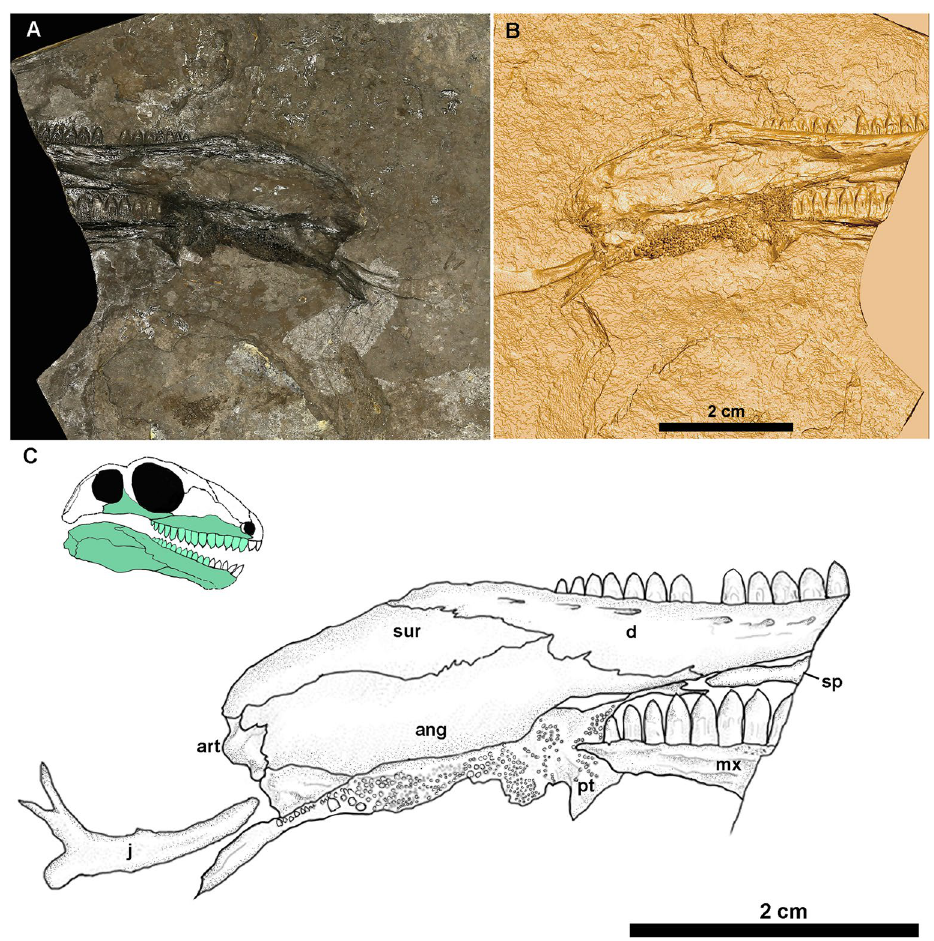
Figure 1. Holotype of Melanedaphodon hovaneci gen. et sp. nov., CM 93778. ( A ) Photograph showing the negative relief/natural mould. ( B ) Digital three-dimensional rendering of the CT data in positive relief. ( C ) Interpretative drawing of specimen based on micro-CT data and original fossil. Top left corner shows a reconstruction of the skull in lateral view with the preserved cranial elements highlighted. Anatomical abbreviations: ang angular, art articular, d dentary, j jugal, mx maxilla, pt pterygoid, sur surangular, sp